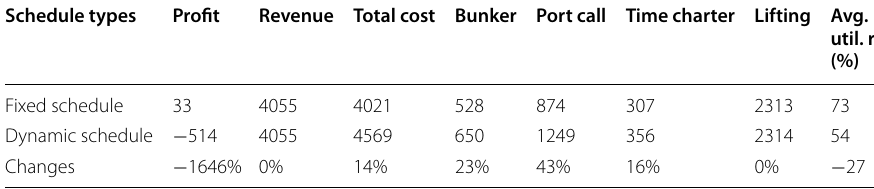
Table 6 Results of LSNDP under fixed schedule and dynamic schedule (in thousand USD) Schedule types